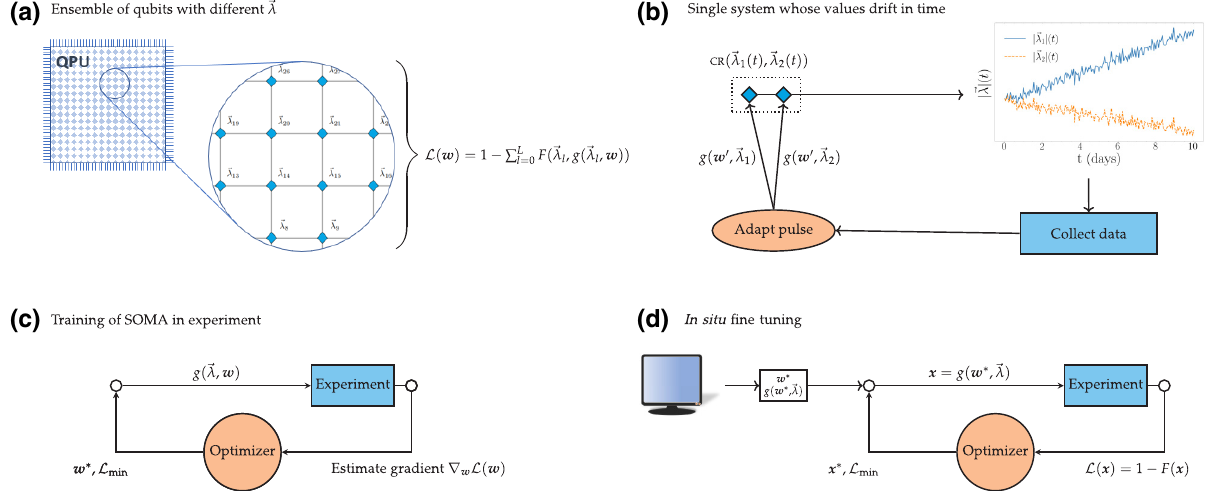
FIG. 3. Four diagrams describing two possible use cases of SOMA and two possible experimental implementations of SOMA BP, respectively. (a) We consider a chip with several qubits, each one with its own Hamiltonian parameter (cid:4) λ . We assume parameter variations δ (cid:4) λ to be so large that robust pulses are generally ineffective. (b) In the second use case, we consider a single system, the parameters of which vary with time. Pulses are trained on the average cost function over ensembles of qubits. (c) The approximator is trained directly on the experimental setting by using a gradient estimator, in this case a policy gradient [63], which usually requires large numbers of samples to be drawn from the system. (d) The regressor is first trained first in open-loop simulation and then used as an ansatz for a closed-loop optimization, which leaves the neural-network parameter untouched but modifies the output amplitude parameter (or, alternatively and if possible, the input parameters) to maximize the fidelity for specific experimental configurations. The optimization routine can be freely chosen among gradient-free algorithms, such as Nelder-Mead in Ref. [43]. This method can be a viable option if the experimental setting can be simulated with sufficient